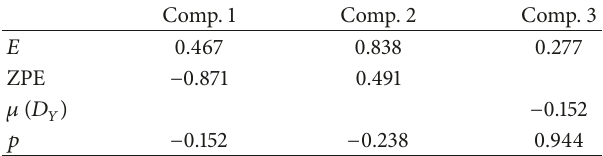
Table 9: The parameters of the MLR model established by Wang Deng-Ju.